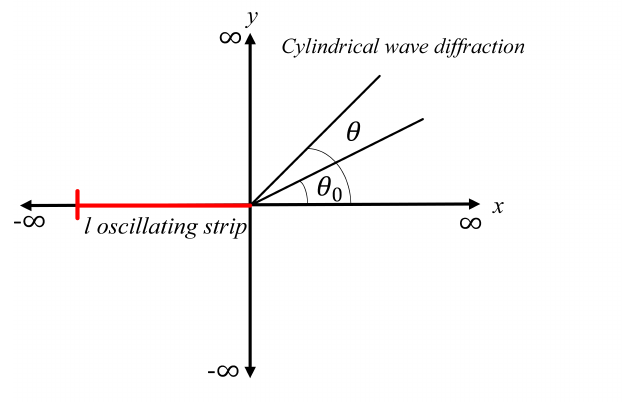
Figure 1. Geometry of the